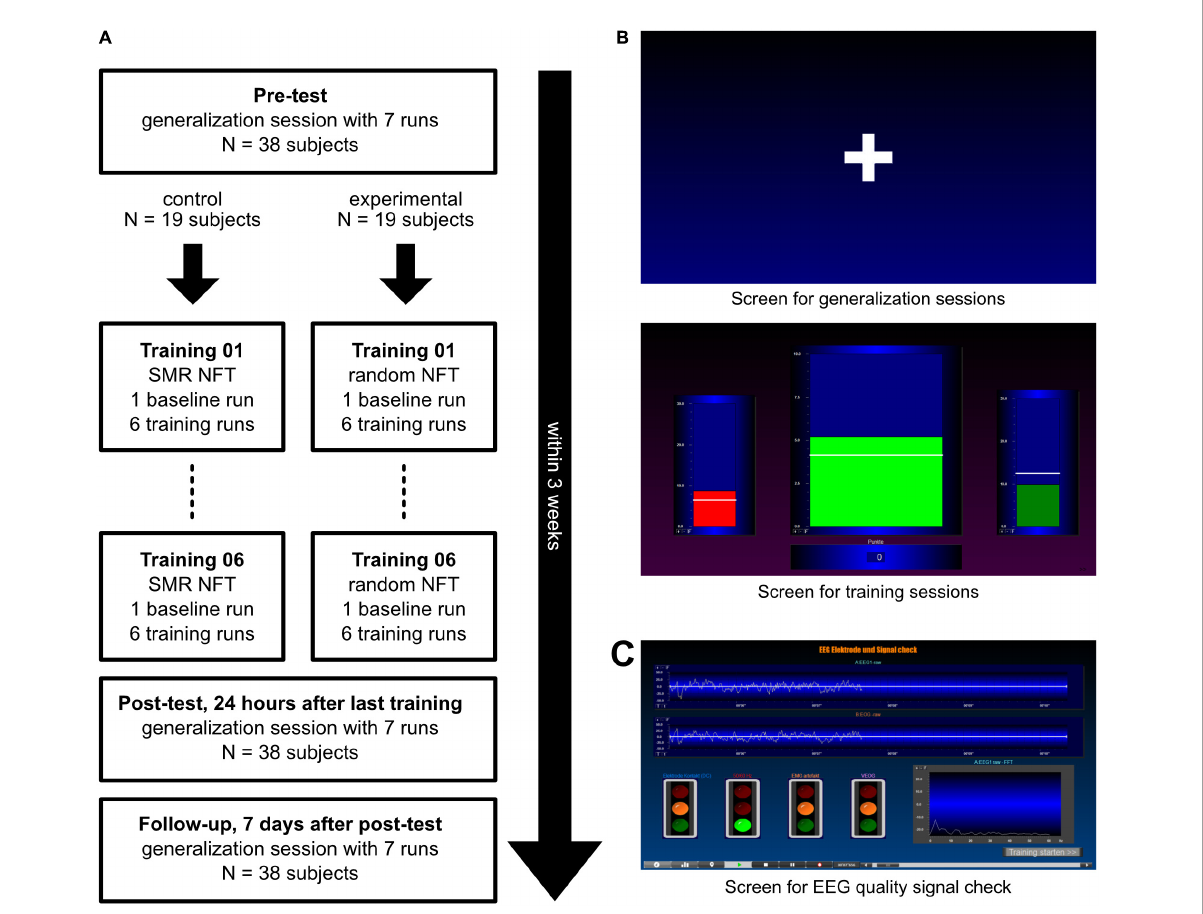
FIGURE1 Procedure and illustration of the presented screens. (A) After a pre-test, subjects were split into two groups: The experimental group received 6 sensorimotor rhythm (SMR) neurofeedback training (NFT) sessions while the control group performed six NFT sessions with feedback in a random 4 Hz frequency range between 7 and 20 Hz. After the NFT sessions, every subject performed two generalization sessions. (B) In the generalization sessions (top panel), participants saw a white fixation cross in the center of the screen. In the training sessions (bottom panel), three moving bars were displayed: Theta (left bar, 4–7 Hz), the frequency to be trained (middle bar; SMR, 12–15 Hz, in the experimental group, and a random 4 Hz frequency band in the control group) and Beta (right bar, 21–35 Hz). White lines depict individual thresholds. (C) The EEG data quality signal check was displayed before the start of every session and showed the biosignals of the EEG and EOG electrodes (top) as well as a fast fourier transformation (FFT) graph to detect 50 Hz artifacts (bottom